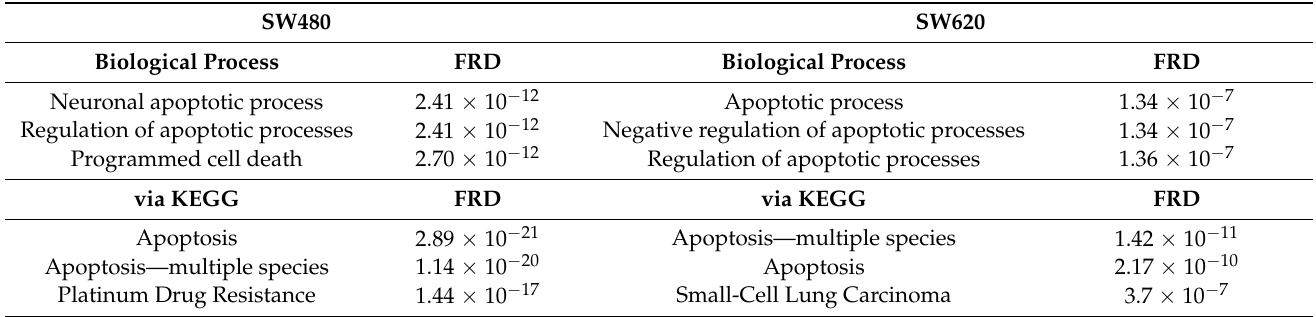
Figure 6. Representative network of LMPE-modulated proteins predicted by STRING ® for cell lines SW480 ( A ) and SW620 ( B ). Table 1. Biological processes and KEGG pathways after the STRING ® analysis of LMPE-modulated proteins for SW480 and SW620 cells. Analysis of protein interactions.